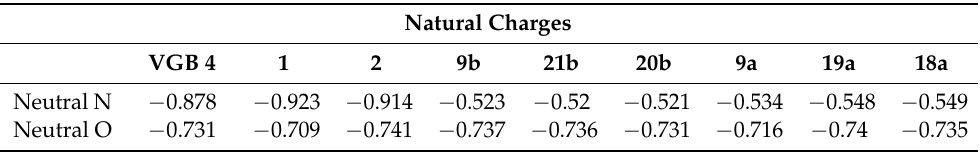
Table 1. Partial natural type charges of all molecules-( S) -enantiomers under study, according to the DFT analysis.